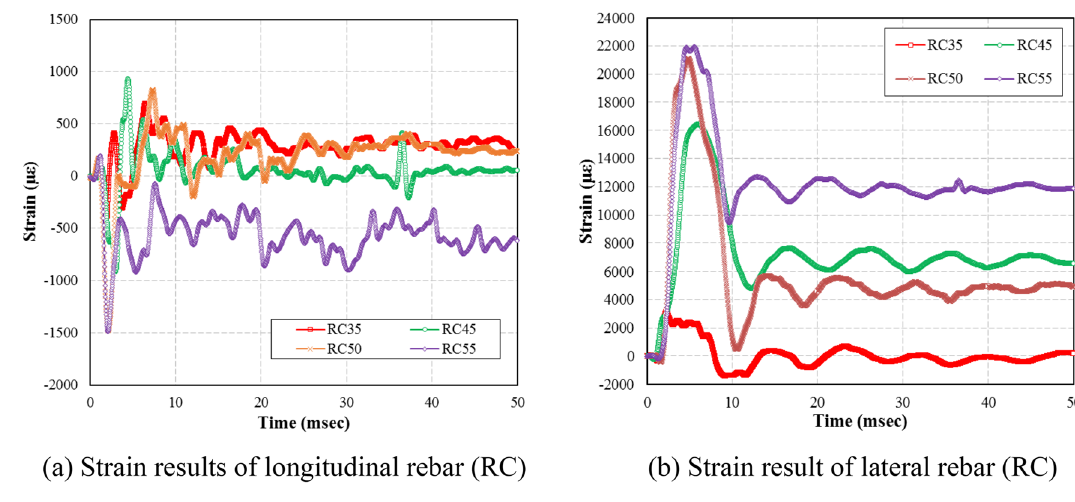
Figure 11. Steel strain results. ( a ) Strain results of longitudinal rebar (RC). ( b ) Strain result of lateral rebar